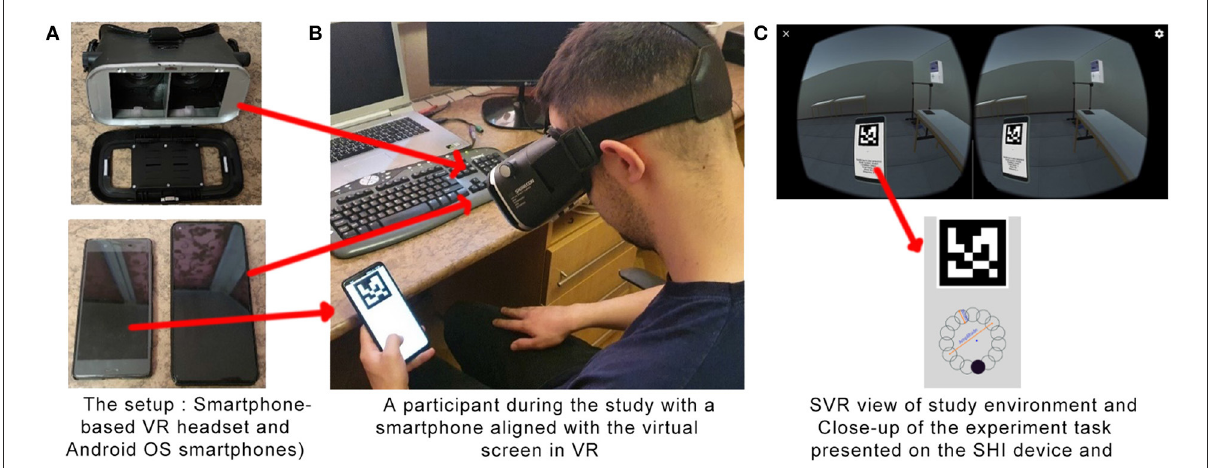
FIGURE9 Study apparatus. (A) The setup: Smartphone based VR headset and Android OS smartphones. (B) A participant during the study with a smartphone aligned with the virtual screen in VR. (C) SVR view of study environment and Close-up of the experiment task presented on the SH1 device.